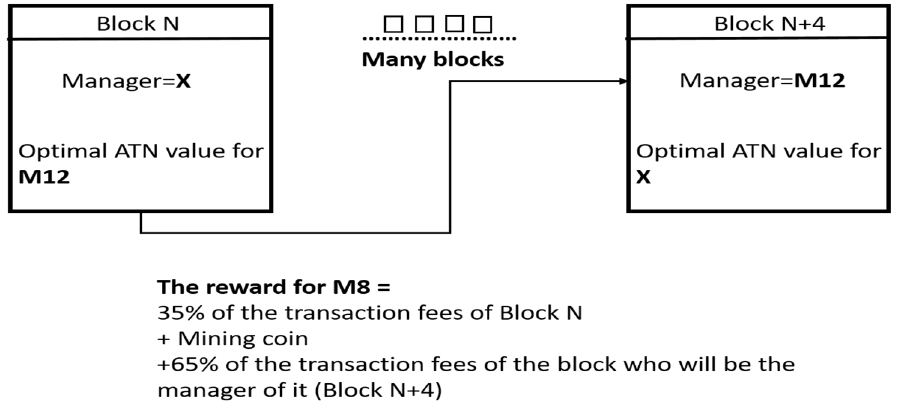
Figure 5. Reward value calculation.